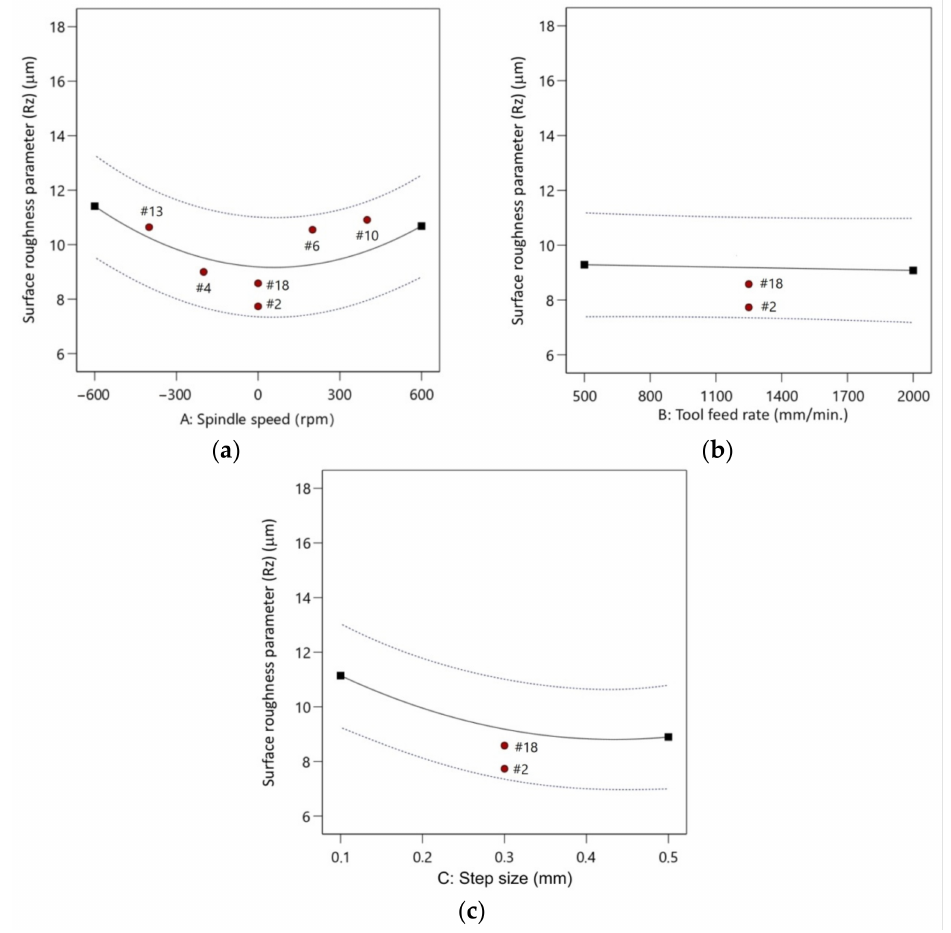
Figure 15. The plots showing the effect of: ( a ) spindle speed; ( b ) feed rate; and ( c ) step size on the parameter Rz.